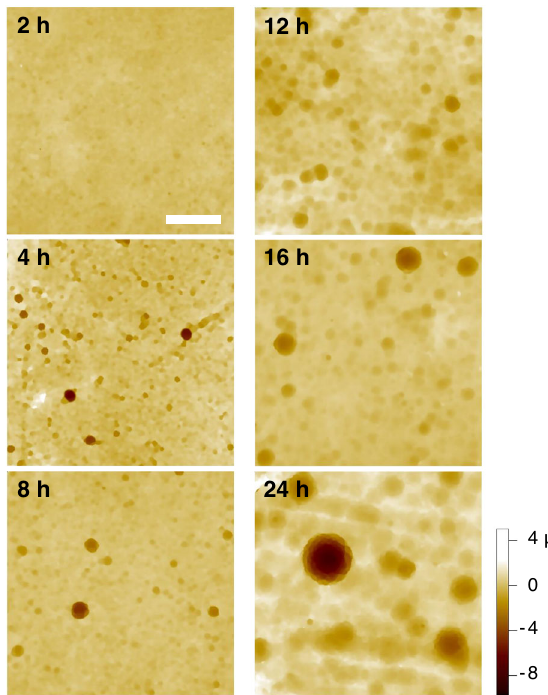
Fig. 4 2D VSI maps showing the evolution of surface topography for reaction times from 2 to 24 h. This advanced degradation phase is characterized by the formation of circular pits. (The scale bar is 100 µm. The z scale is set to zero for the respective modal value of the height distribution.). the rough background structure generated in the initial phase. Note that the 3D maps are exaggerated in the z -direction. In fact, the pits are very shallow (ratio of depth/diameter = 0.05 – 0.10), hardly exceeding the basic roughness that dominates after 2 h. This speci fi c degradation pattern does not change signi fi cantly with increasing reaction time (Fig. 4), suggesting a steady-state behaviour. Only for the latest time period (16 – 24 h), lateral growth of the pits is visible. The same applies to the vertical extension, as